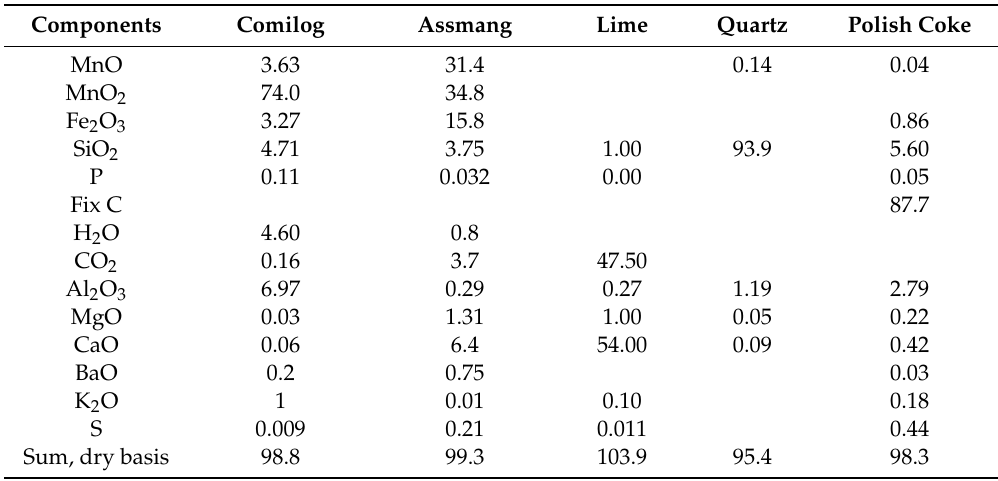
Table 1. Raw material compositions (dry basis),